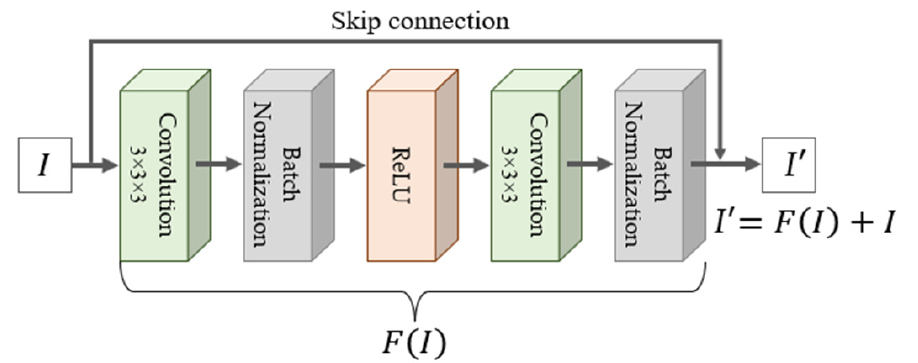
Figure 6. A residual block in ResNet.